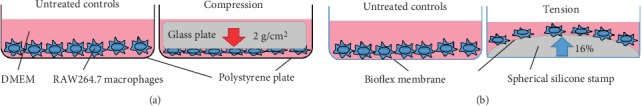
In vitro setup for the application of static compressive (a) and tensile isotropic strain (b). DMEM = Dulbecco‘s modified Eagle medium.